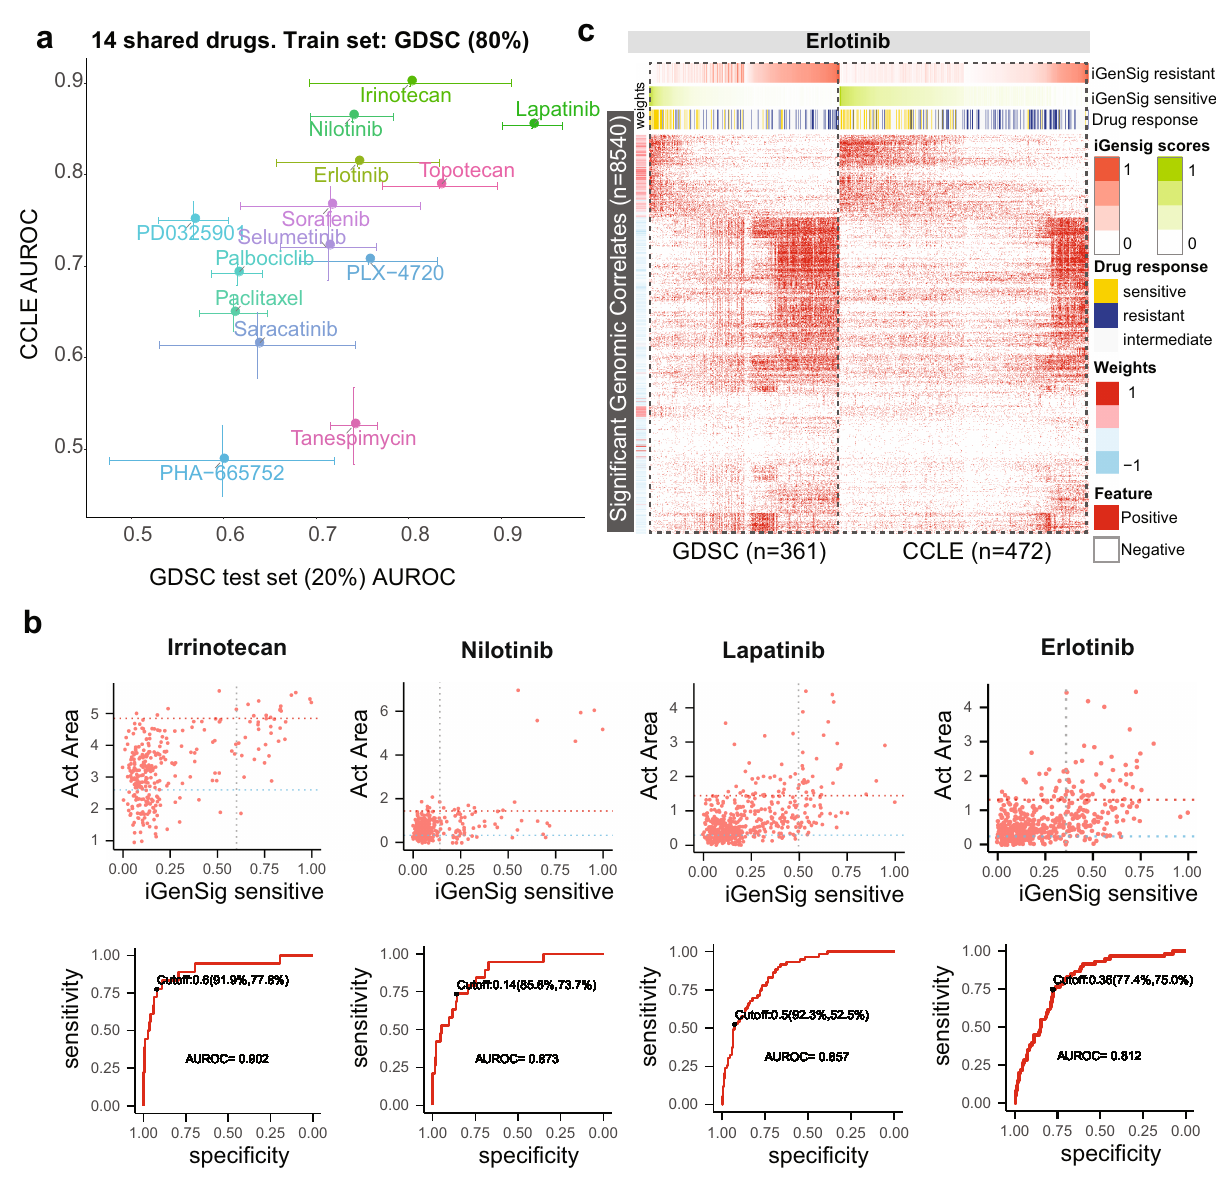
Fig. 3 Predictive values of iGenSig models developed from the GDSC pharmacogenomic dataset on the sensitivity of CCLE pro fi led cell lines to the shared drugs. a The performance of GDSC iGenSig models in predicting the responses of GDSC testing cell lines and CCLE cell lines to 14 drugs shared between the two datasets. 80% of GDSC cell lines are used for building the iGenSig models and 20% of GDSC cell lines are used for testing. 100% of CCLE cell lines are used for cross-dataset validations. If the same drug is pro fi led by both GDSC batch 1 and 2, the drug sensitivity data from batch 1 are used in the analysis. The error bars show standard deviations. b The predictive values of the iGenSig models developed from GDSC data on the CCLE cell lines treated with Irinotecan, Nilotinib, Lapatinib, or Erlotinib. The upper panel shows the correlation between the iGenSig scores and the Act Areas of the respective drugs for CCLE cell lines. The horizontal dashed lines show the cut-offs for sensitive (red) and resistant (blue) calls. The vertical dashed line shows the optimal cut- off for iGenSig scores determined based on AUROC. The lower panel shows the ROC curves of iGenSig scores in determining the sensitive cell lines vs non- sensitive cell lines. c GDSC and CCLE cell lines show consistent integral genomic signature that correlates with Erlotinib responses. The signi fi cant genomic features ( n = 8540) based on K-S tests are shown in the fi gure. The GDSC and CCLE cell lines are fi rst sorted by their sensitive iGenSig scores; the cell lines with sensitive iGenSig scores less than the median are then sorted by the resistant iGenSig cores. The cell lines that have been tested for Erlotinib chemical perturbations are shown in the fi gure, and the sensitive and resistant cell line subjects are indicated as yellow and blue therapeutic responses of EGFR inhibition and its excellent cross- dataset performance.